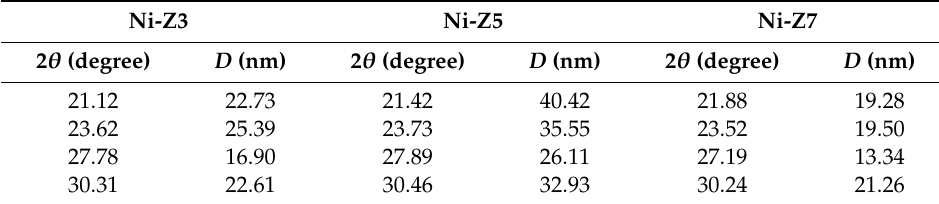
Table 7. Crystal grain size of Ni-Z3, Ni-Z5, and Ni-Z7